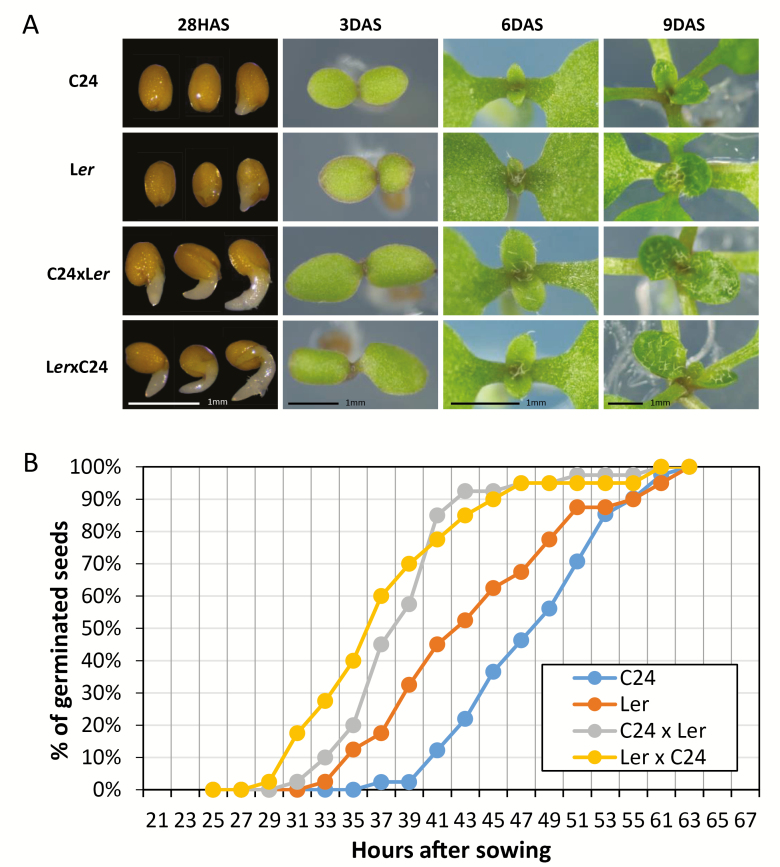
Earlier germination and leaf emergence in C24×Ler hybrids relative to parents. (A) Photographs of parents and reciprocal hybrids at 28 h after sowing (HAS), 3, 6, and 9 DAS. (B) Germination of C24×Ler hybrids and parents (see also Zhu et al., 2016). Germination was scored as the first visible sign of root emergence.